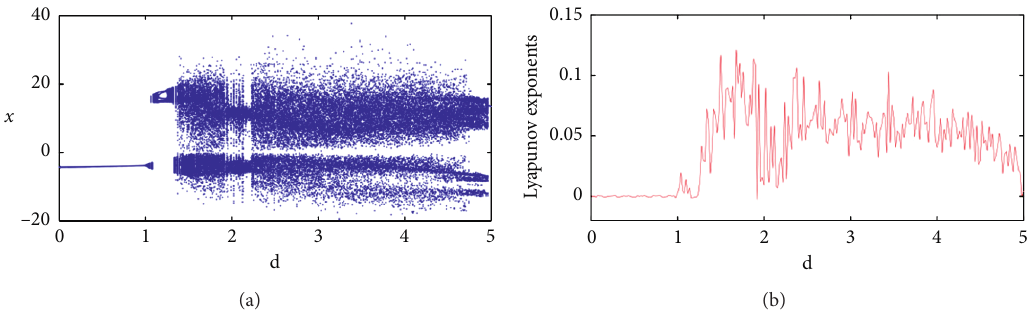
Figure 3: Bifurcation diagram (a) and Lyapunov exponents variation (b) of the total system risk value x with time-lag risk intensity d .